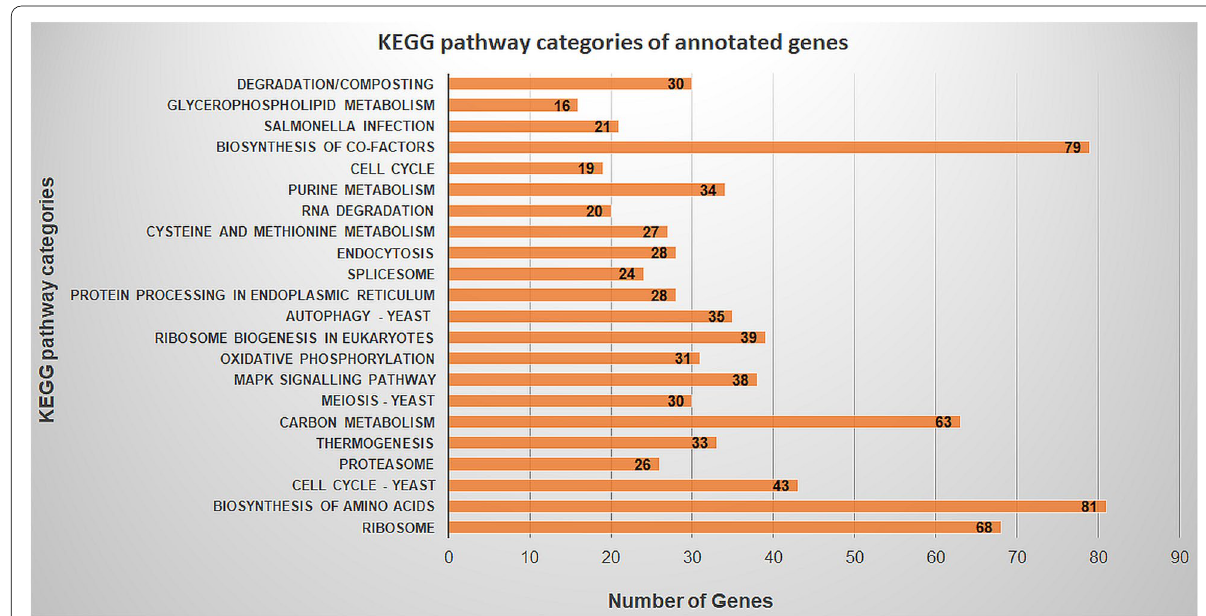
Fig. 4 Major KEGG pathway categories of the genes annotated from G. butleri genome